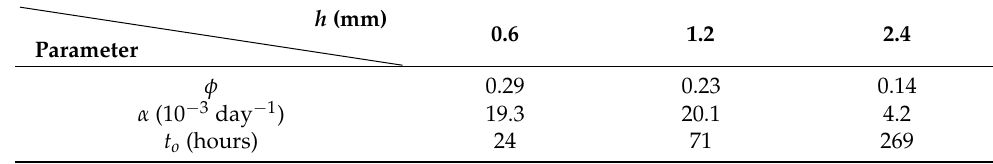
Table 2. Non-Fickian parameters of AS4/8552 carbon/epoxy composites.